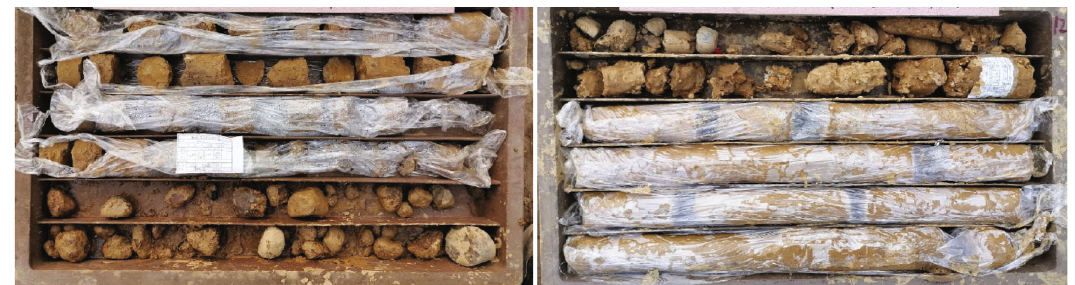
Figure 7: The relevant core of No. 2 drill pumping